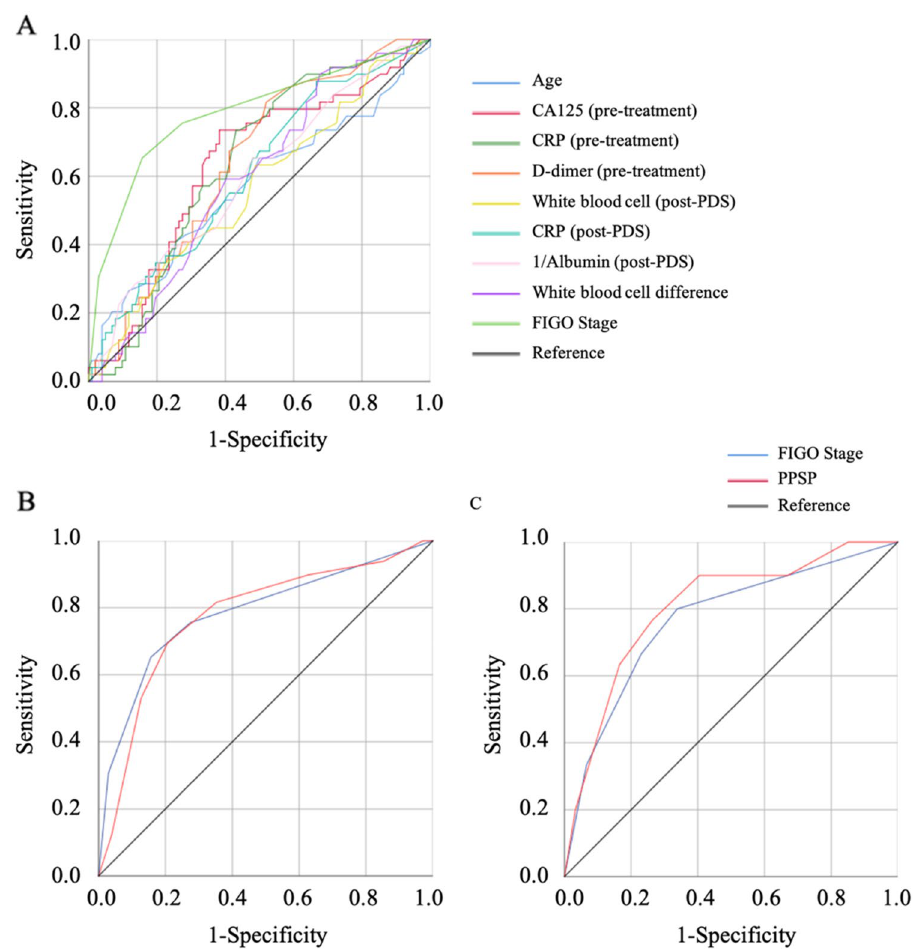
Figure 1. The ROC curves of each factors in the current cohort. All factors showed a high AUC with significant differentiation ( A ). The FIGO staging marked highest AUC. The PPSP showed slightly lower AUC than the FIGO staging for PFS (0.776 vs. 0.809) ( B ), and the PPSP and the FIGO staging showed similar AUC value for OS (0.809 vs. 0.806) ( C